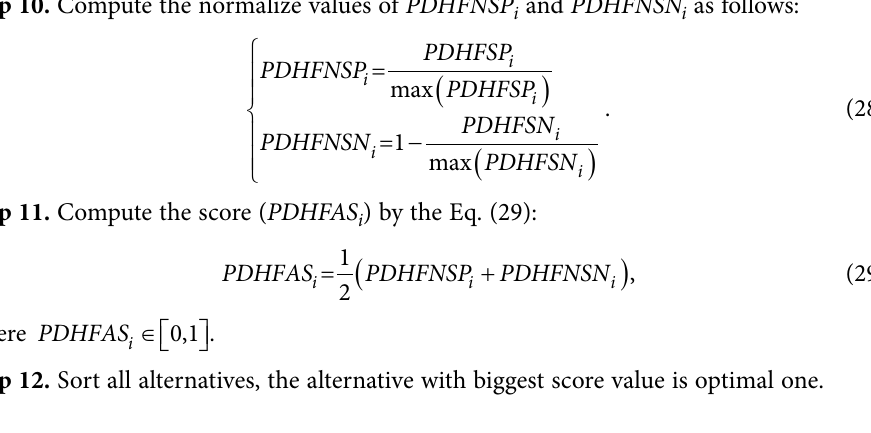
Construct k decision